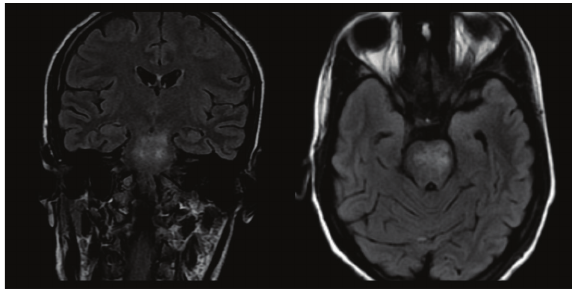
Figure 2: Coronal and axial FLAIR images showing pontomesen- cephalic hyperintensities suggestive of PRES syndrome.